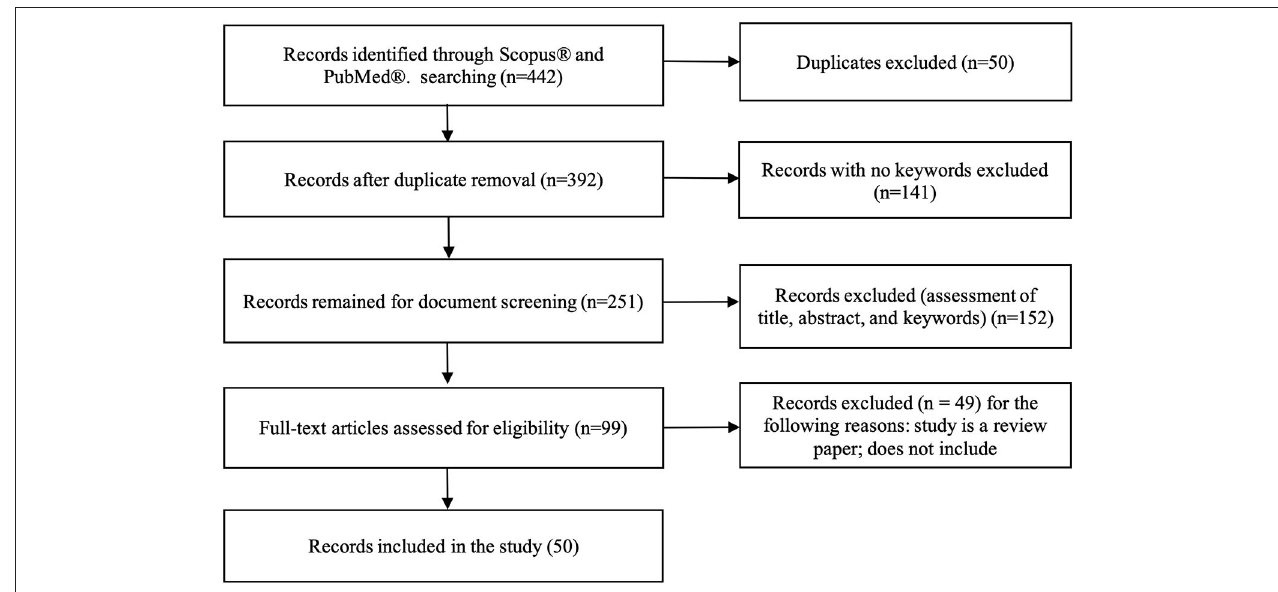
FIGURE 3 | Flowchart illustrating literature search process and extraction of studies meeting the scoping review inclusion